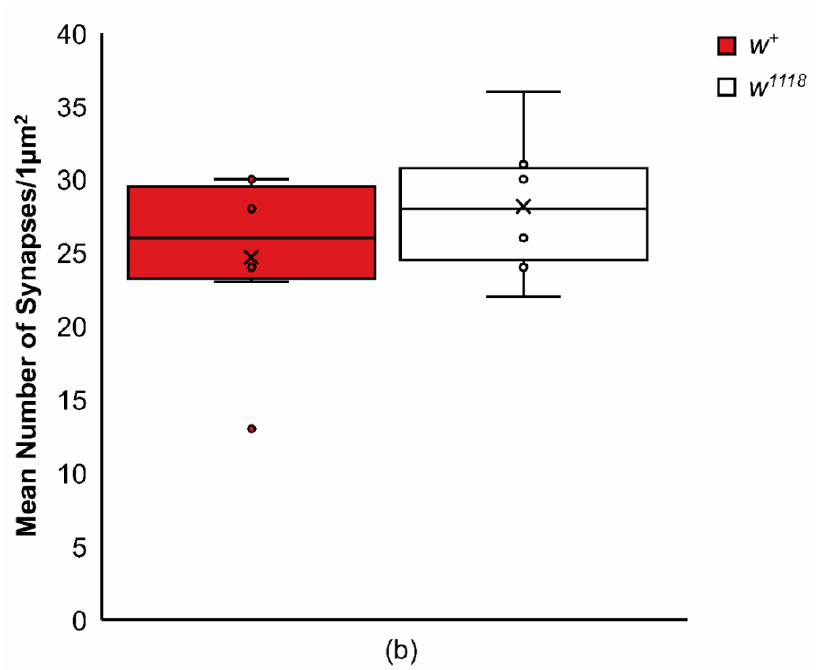
Figure 8. The average number of synapses are not significantly different between wildtype and w 1118 mutants. ( a ) Representative micrographs of wildtype Canton-S ( w + ) and w 1118 mutants in an area adjacent to the mushroom body calyces are shown. Scale bar = 1 mm. ( b ) The average number of central synapses were quantified in wildtype and w 1118 mutants; w 1118 mutants were not significantly different from wildtype ( t 10 = 1.04, p = 0.32, n = 6).